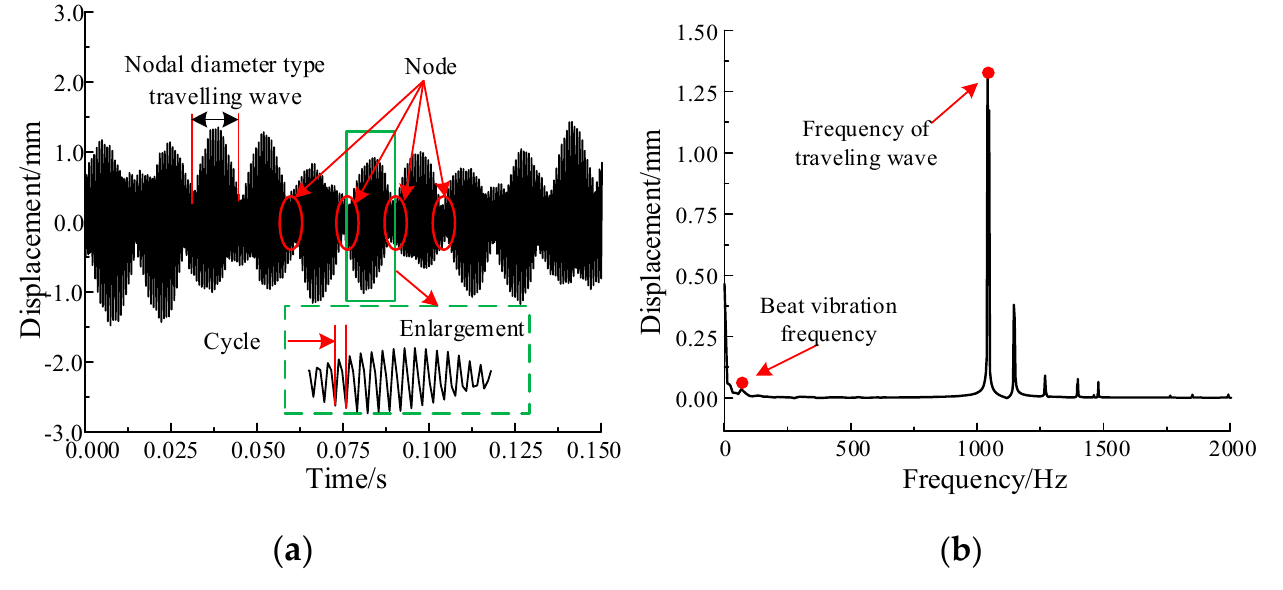
Figure 8. Radial displacement response of rim of L-shaped flexible ring gear. ( a ) Radial displacement response and ( b ) spectrum of radial displacement response.